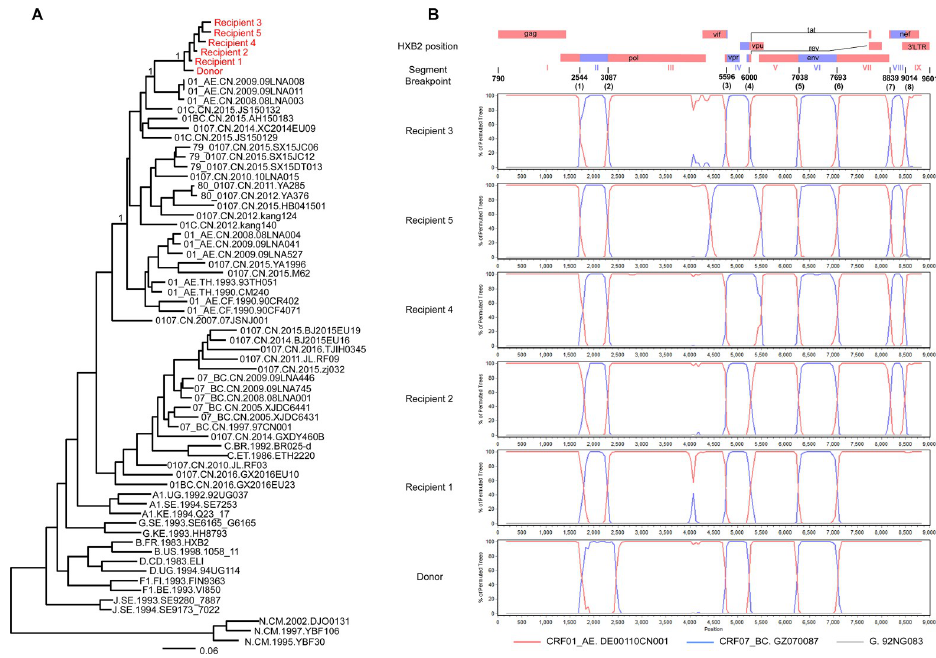
Fig 1. The phylogenetic tree and recombination analysis of NFLG of six HIV-1-infected MSM from Liaoning, northeast China. (A) The phylogenetic analysis of NFLG from six HIV-1-infected MSM (marked red) and reference sequences which were downloaded from HIV database (marked black). Maximum likelihood phylogenetic trees were constructed by Fast Tree and edited by Fig tree v1.4.2. The scale length represents 6% nucleotide sequence divergence. (B) Recombination analysis of six HIV-1 NFLG by using SimPlot (v3.5.1). CRF01_AE and CRF07_BC were used as putative parental sequences according to the online tool HIV Blast and subtype G (14003718) was used as an outgroup. The parameters of analysis were the default except the window size was 350 bp and step size was 50 bp, bootstrap replicate was 250. NFLG, near full-length genomes; MSM, men who have sex with men.